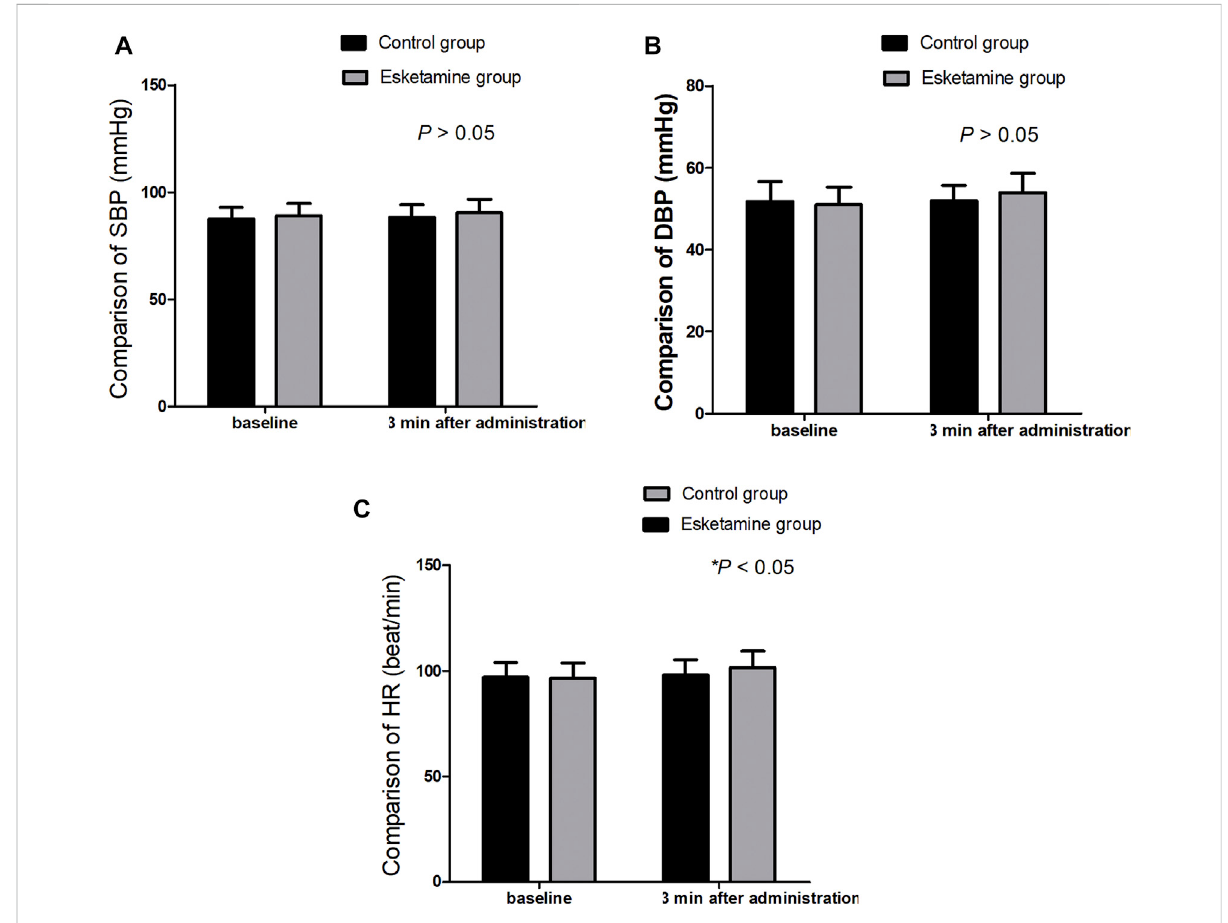
FIGURE 2 (A – C) Comparison of SBP, DBP, and HR between the two groups, * p <